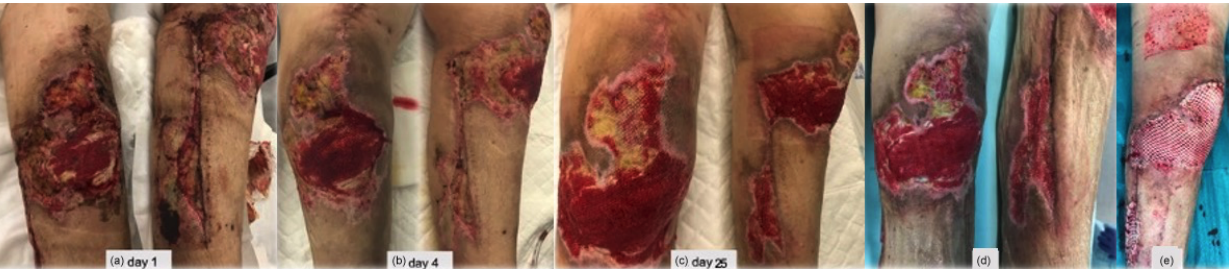
Figure 4. (a) A period of 3 weeks after revision surgery, new debridement of all necrotic areas, interruption of enoxaparin, negative pres- sure dressings, and hyperbaric oxygen chamber treatment were performed. (b–c) Progressive healing of the wound. (d) New debridement. (e) Split-thickness skin graft of the thigh for wound